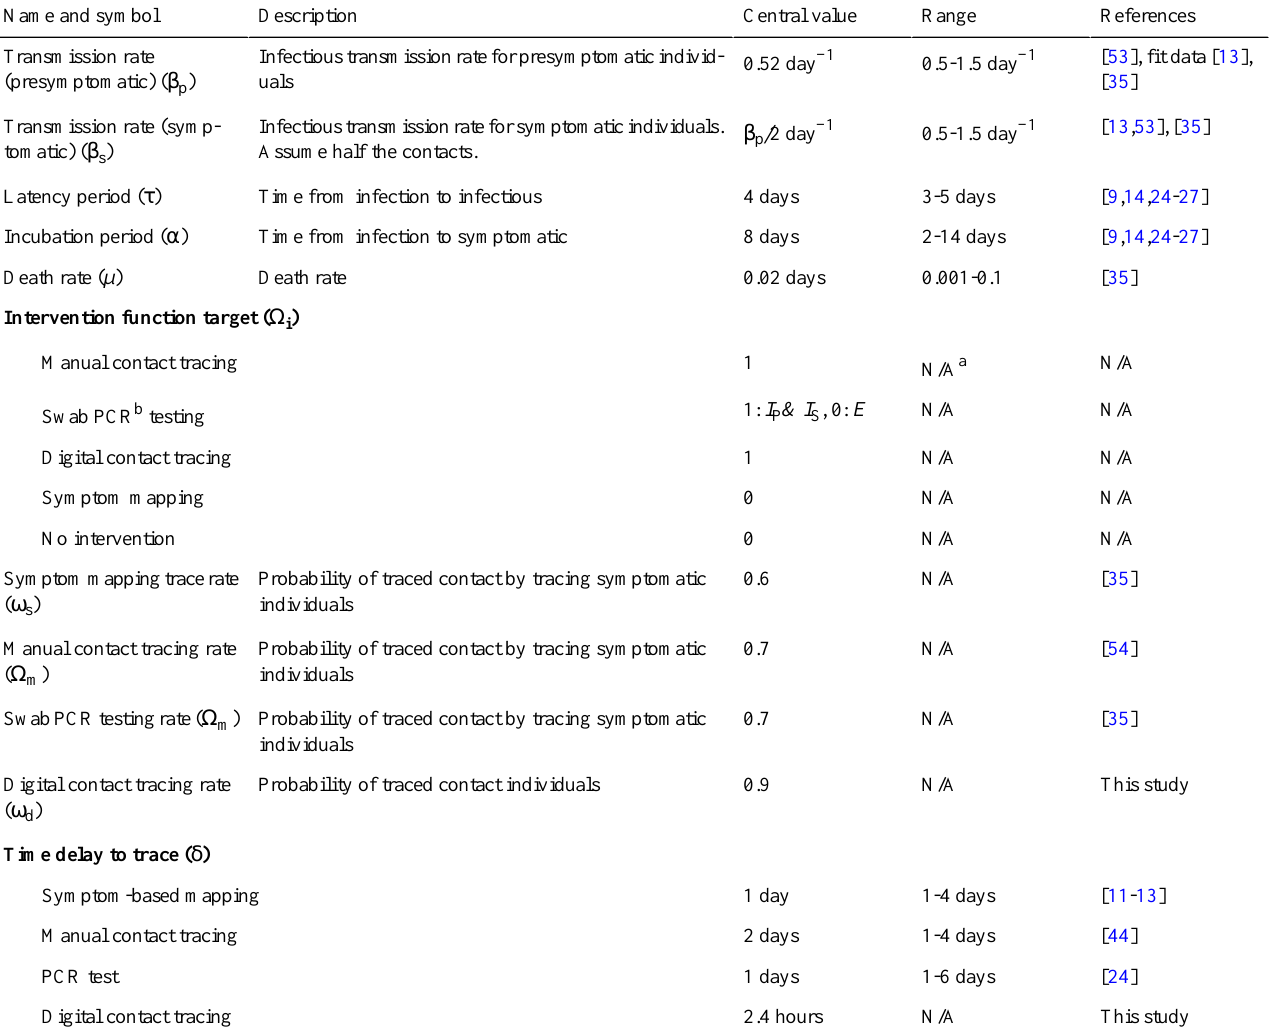
Table 1. Parameters for compartmental infection and intervention model.